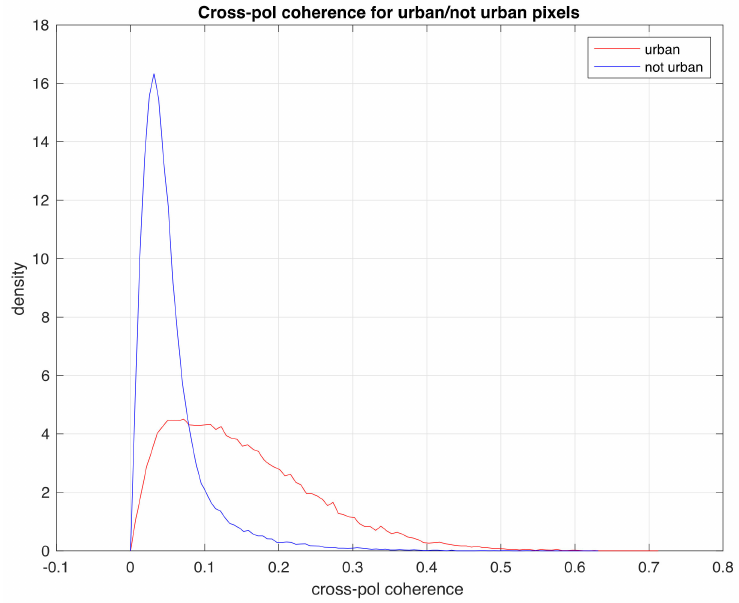
Figure 4. Cross-pol coherence probability density estimation for Lainate,